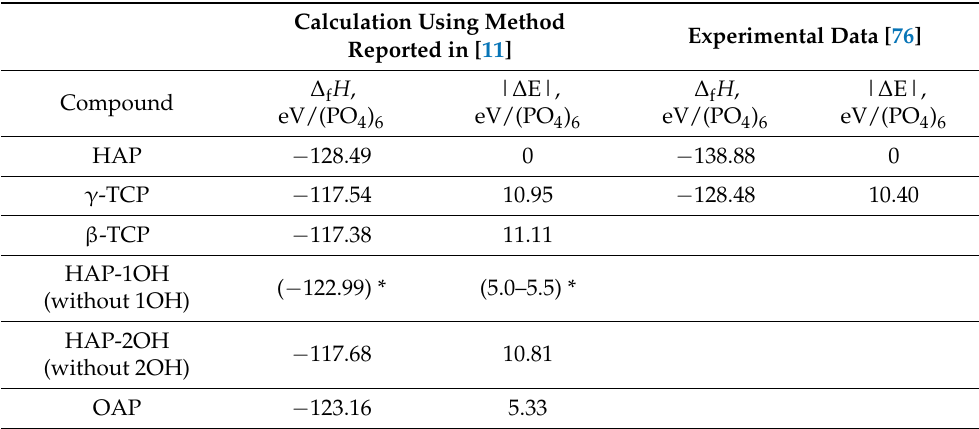
Table 2. Formation energy of hydroxyl group vacancies V 1OH and V 2OH in HAP. (From Kohn-Sham formalism of DFT calculation basically described in work [11,12]).